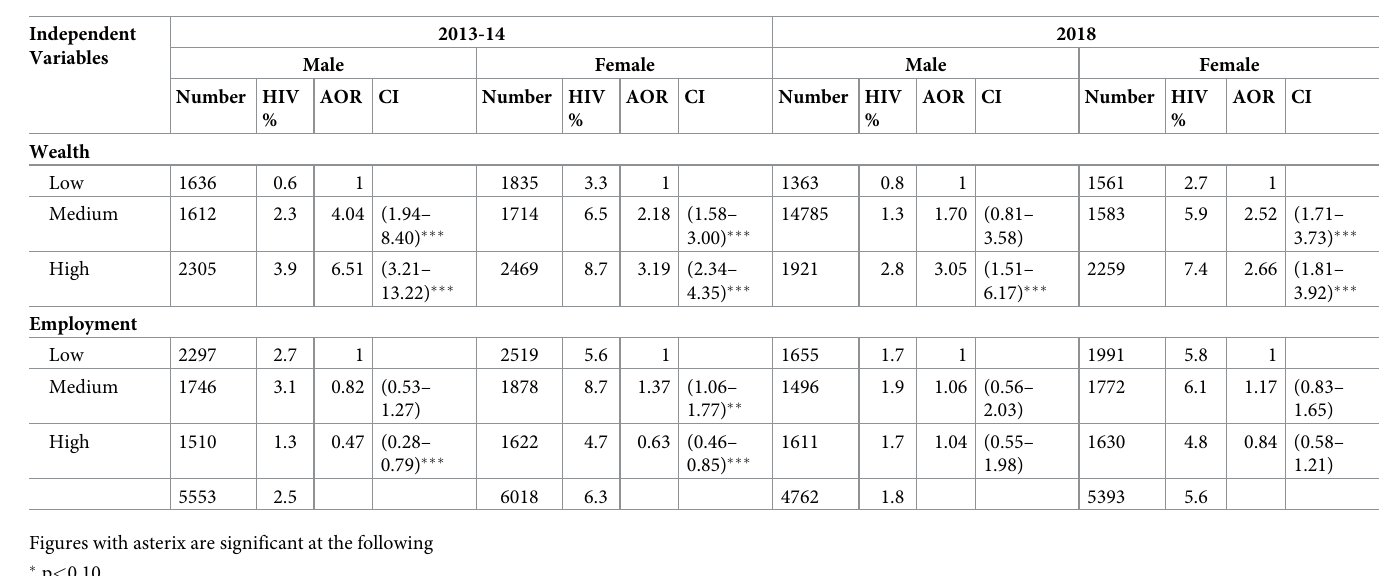
were unemployed. However, professional occupation was associated with higher odds of being infected among both young men and women. Living in neighbourhoods with a high propor- tion of employed residents was associated with lower odds of HIV infection among young women and men. Conversely, living in a neighbourhood with high wealth and education status was associated with higher odds of HIV infection (Table 2). The intercept-only model showed that the overall HIV prevalence varied across neighbour- hoods with a neighbourhood difference of 14% in 2013–14 (results not shown) (see S3 Table). In Model 2, the addition of individual-level variables to the intercept-only model explained more of the variance than the addition of neighbourhood variables (it explained a variance of 62% and a neighbourhood difference of 7% versus 9% and 8%, respectively). The inclusion of both individual and neighbourhood variables in Model 4 explained 62.4% of the variance in HIV prevalence, and the likelihood-ratio test showed that the fit of the model significantly improved compared to the intercept model. The following variables were associated with higher odds of being HIV positive in Model 4: age, urban residence, formerly married, medium wealth and residing in neighbourhoods with high educational attainment and medium-level employ- ment. Educational attainment at the individual level and employment were significantly associ- ated with lower odds of being infected (results not shown) (see S3 Table). For 2018, the intercept-only model showed 13% variation in HIV prevalence across neigh- bourhoods (results not shown) (see S3 Table). In Model 2, the addition of individual-level vari- ables to the intercept-only model explained 58% of the variance and a neighbourhood difference of 11%. The inclusion of both individual and neighbourhood variables in Model